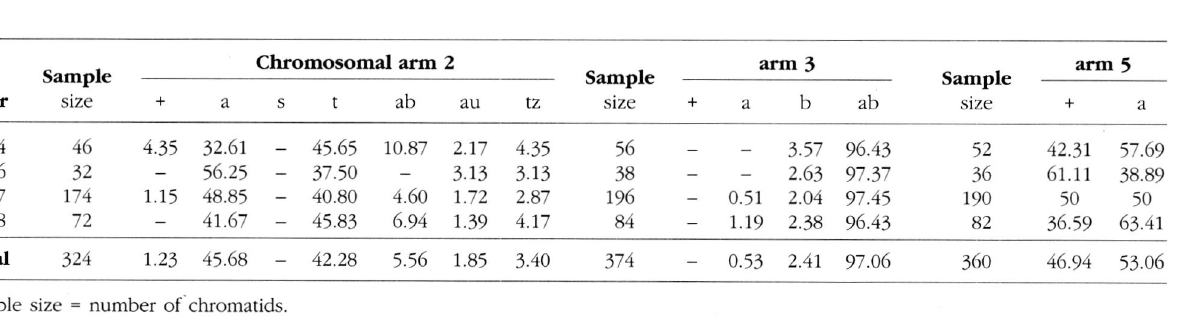
Table IV. - Annual variability of chromosomal inversion frequencies in indoor resting samples of half-gravid females of An. funestus from the Kedougou area.